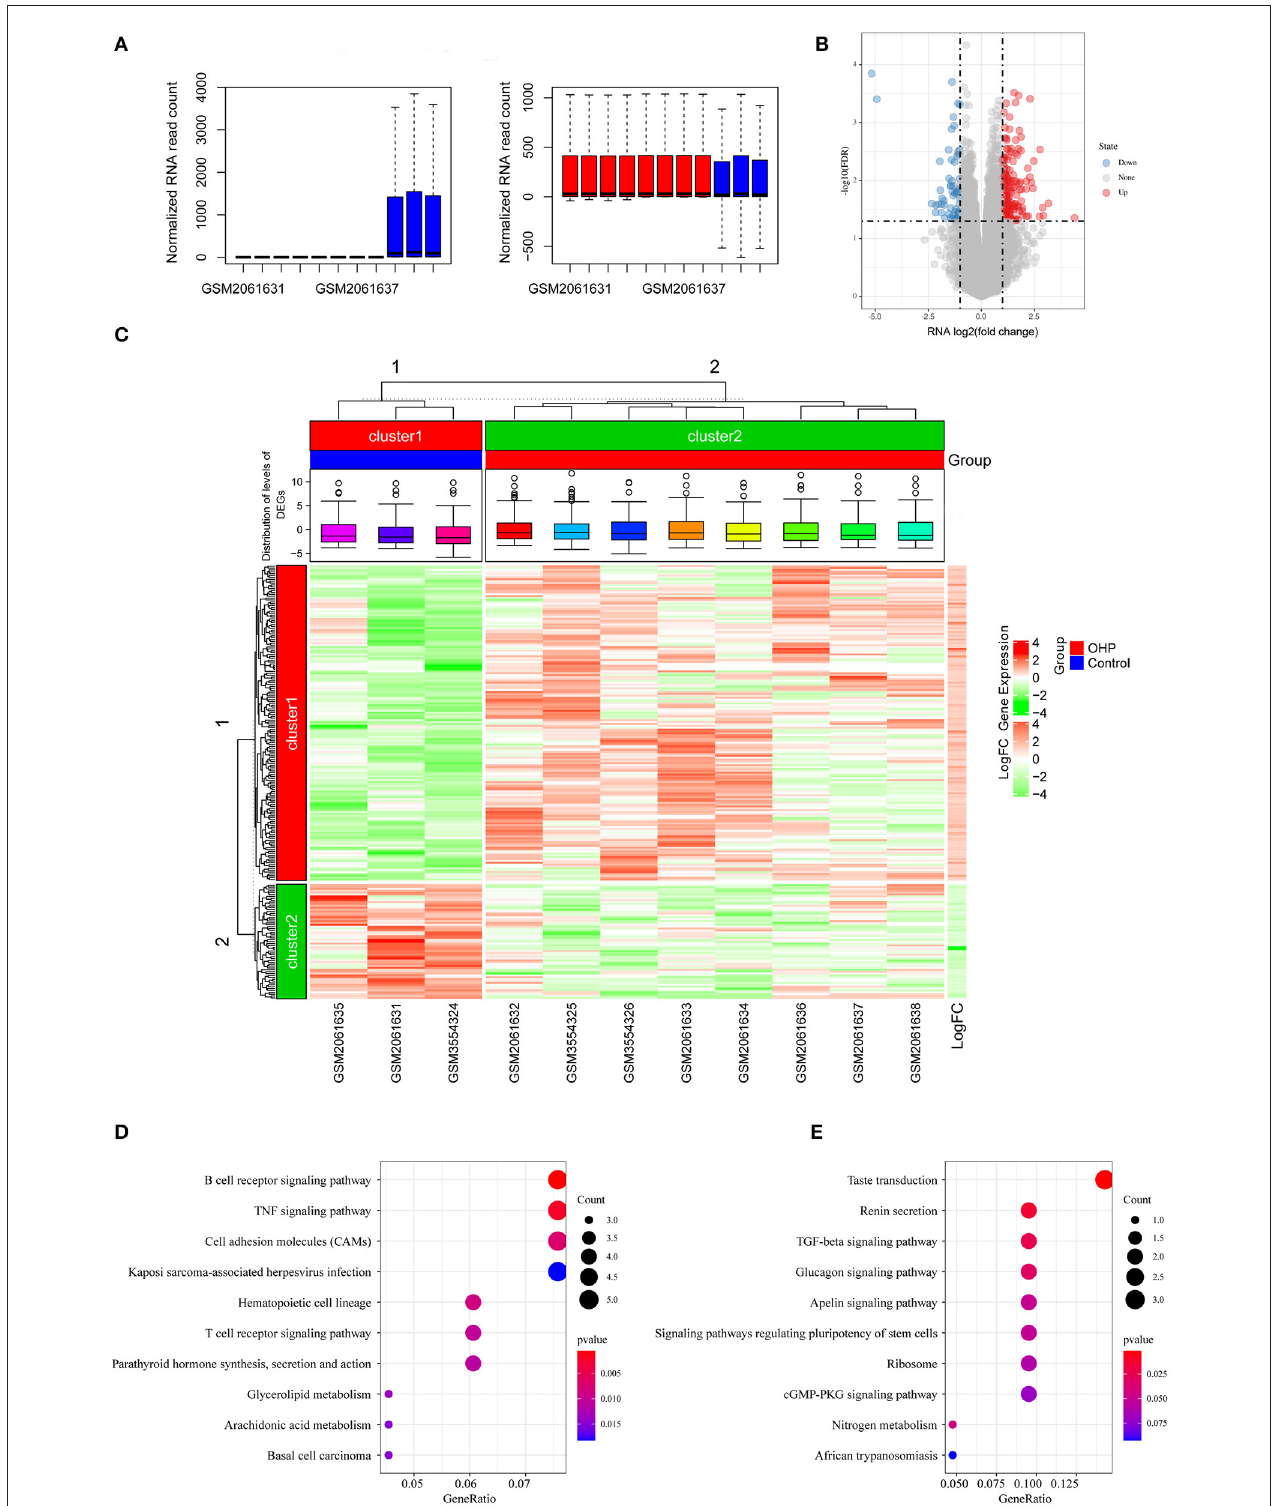
FIGURE 1 | Differentially expressed genes (DEGs) between oxaliplatin-resistant and -sensitive colon cancer cells. (A) Boxplot of the distribution of the sample expression profile before and after the removal of the batch effect. (B) Volcanogram of DEGs. (C) Heatmap of DEGs. (D) Kyoto Encyclopedia of Genes and Genomes (KEGG) enrichment analysis of upregulated DEGs. (E) KEGG enrichment analysis of downregulated DEGs.